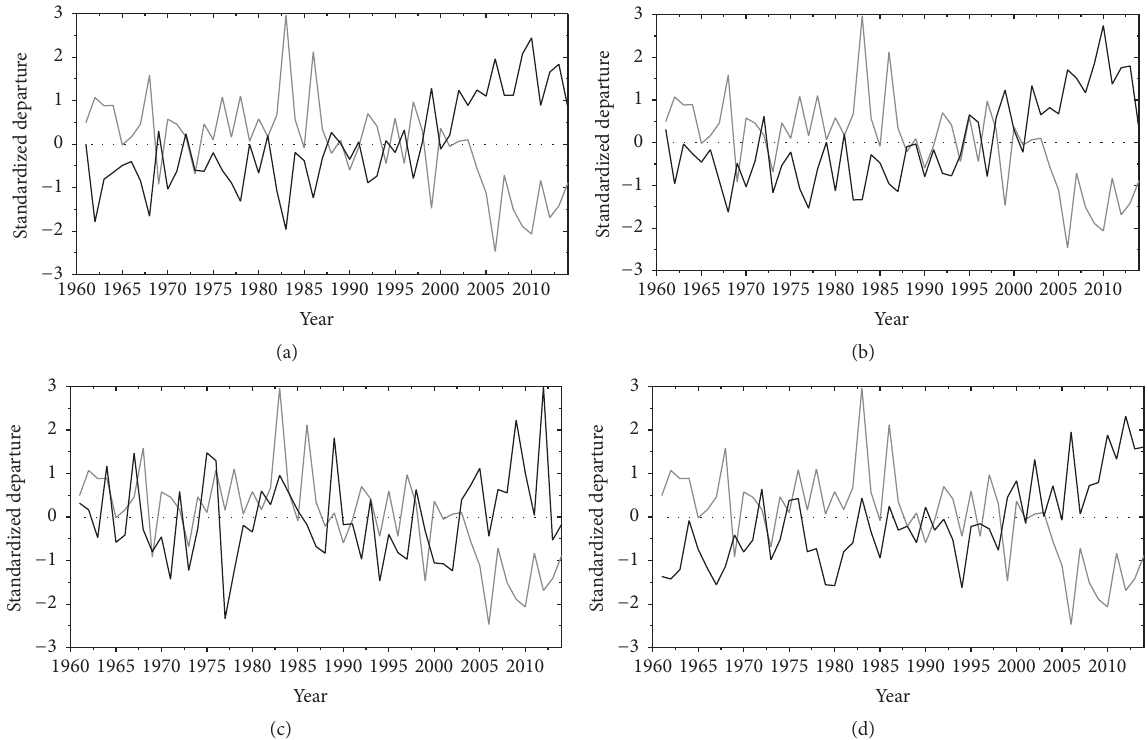
Figure 5: Time series of annual air temperature (a), thawing index (b), annual precipitation (c), and freeze first date (d) in TRSR (black line) with the time series of freeze depth (grey line). All variables were standardized with respect to their mean and standard deviation.